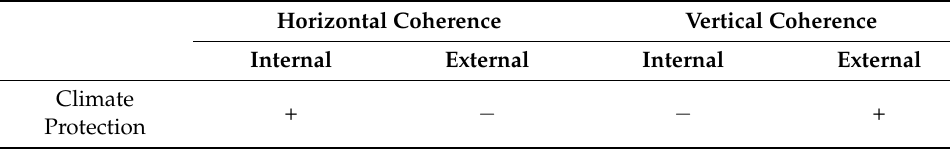
Table 3. Coherence within Thuringian climate